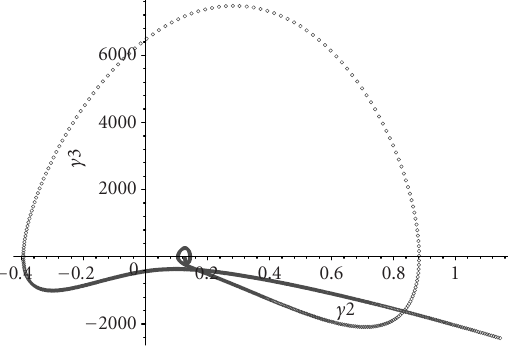
Figure 5.4. This curve is a magnification of the motion in the neighborhood of the endpoint of Figure 5.3, starting below the axis and moving to the left. It makes another loop and ends in a smaller